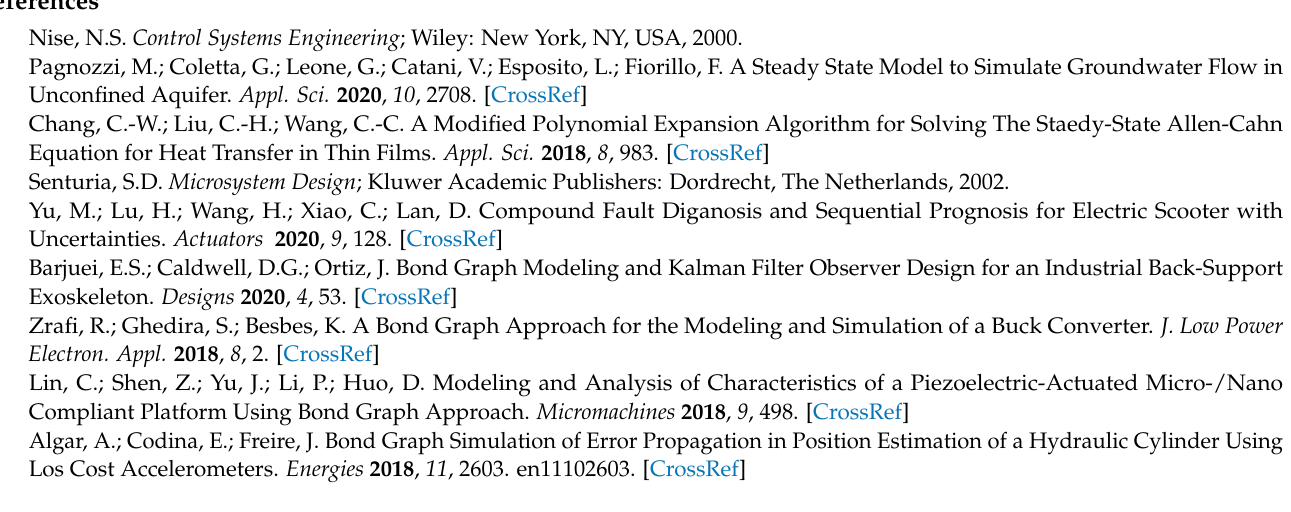
Figure A7. Three-phase current for i 3 using the equivalent reduced circuit and